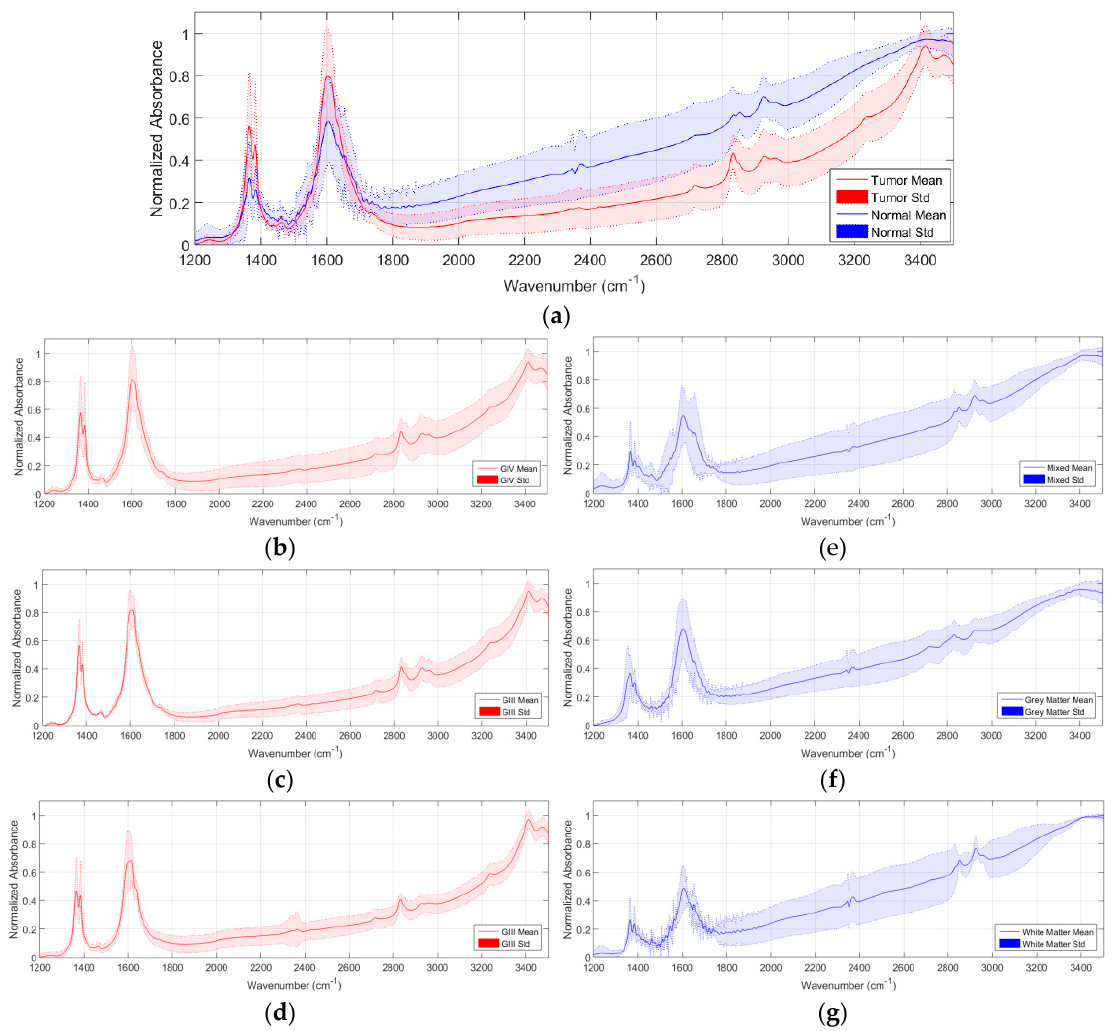
Figure 1. Average and standard deviation of the pre-processed spectroscopic signatures. ( a ) Tumor vs. normal samples; ( b – d ) Grade IV, III, and II tumor samples, respectively; ( e – g ) Mixed, grey matter, and white matter normal samples, respectively.